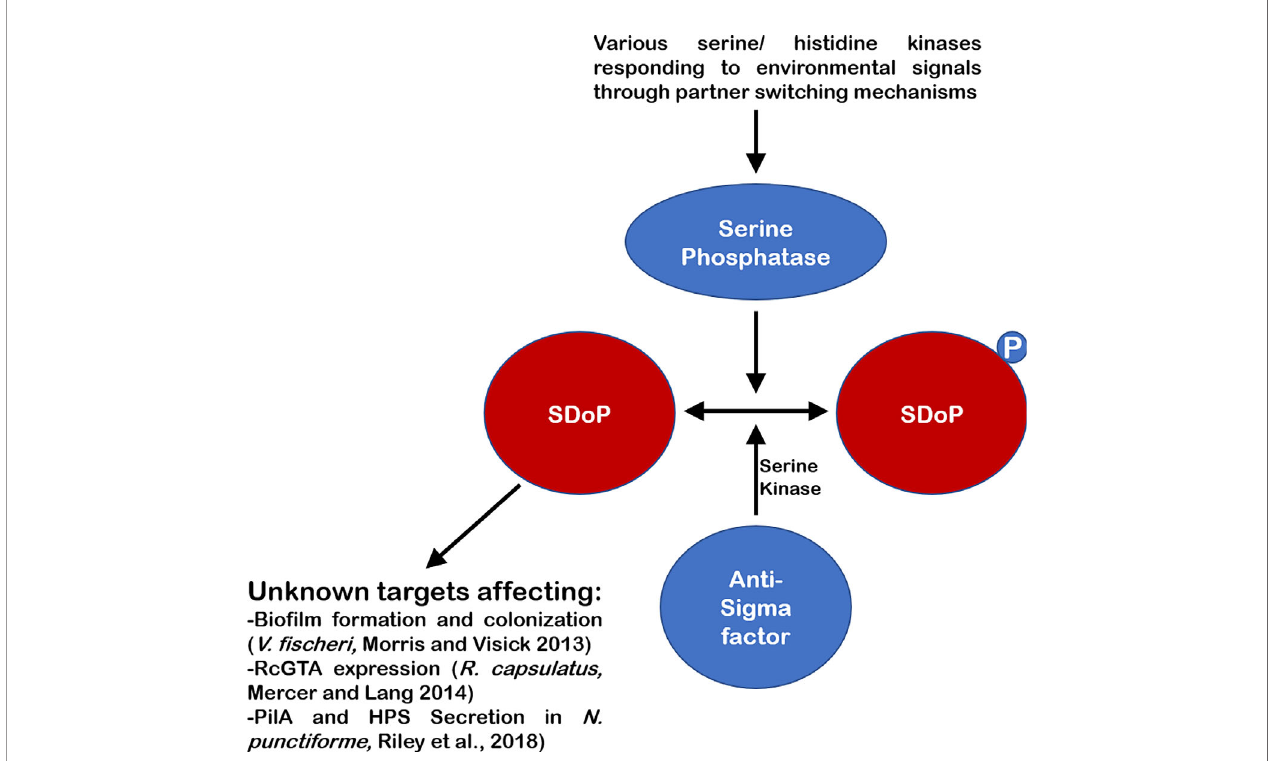
FIGURE 2 | Schematic of several non-canonical SDoPs. Environmental signals lead to activation of various partner-switching mechanisms, leading to the activation of a serine phosphatase which can dephosphorylate the SDoP at a conserved serine residue. This dephosphorylation allows the SDoP to affect gene expression through various unknown targets to produce various phenotypes in different bacteria. These systems also generally contain an anti-Sigma factor which has serine kinase activity and phosphorylates the SDoP, inactivating it, when the signal leading to activation of the pathway is no longer